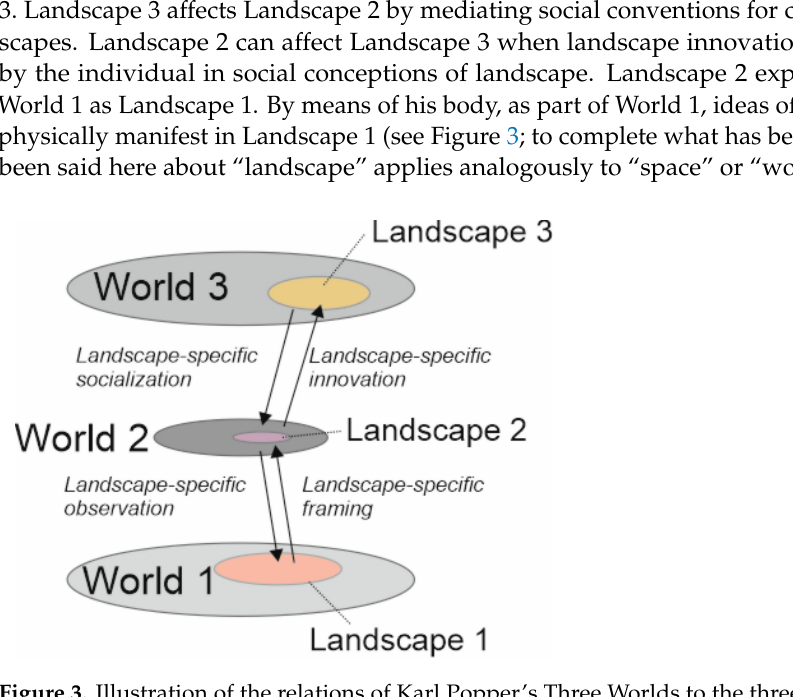
Figure 3. Illustration of the relations of Karl Popper’s Three Worlds to the three landscapes in the sense of the theory used here, but also of the relations of Landscapes 3 and 2 as well as 2 and 1 (own illustration firstly shown in [36], adapted here).